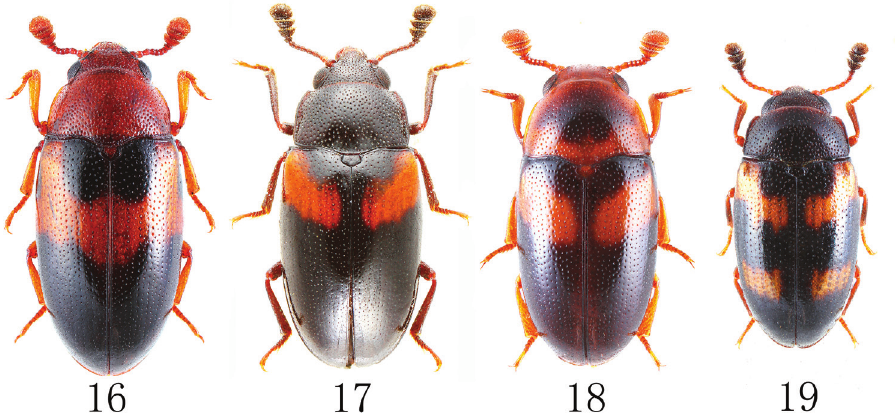
Figures 16–19. Habitus of Chinese species of Dacne in dorsal view ( Dacne zonaria taiwana is excluded). 16 Dacne ( Dacne) japonica 17 Dacne ( Xenodacne) hujiayaoi 18 Dacne ( Dacne) picta 19 Dacne ( Xenodacne) tangliangi . Scale = 2 mm. Abdomen with distinct coxal lines on first ventrite nearly attaining posterior margin. Legs with tibia not dilated at apex. Scutellum pentagonal, finely and sparely punctured. Elytra margined basally; widest at middle, then gradually narrowing to apex;